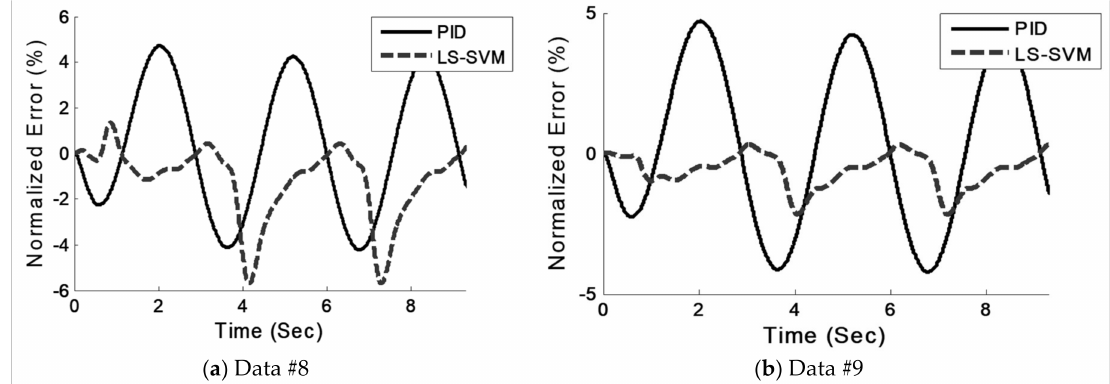
Figure 9. Comparison of the normalized errors of Model 2 in di ff erent tests.